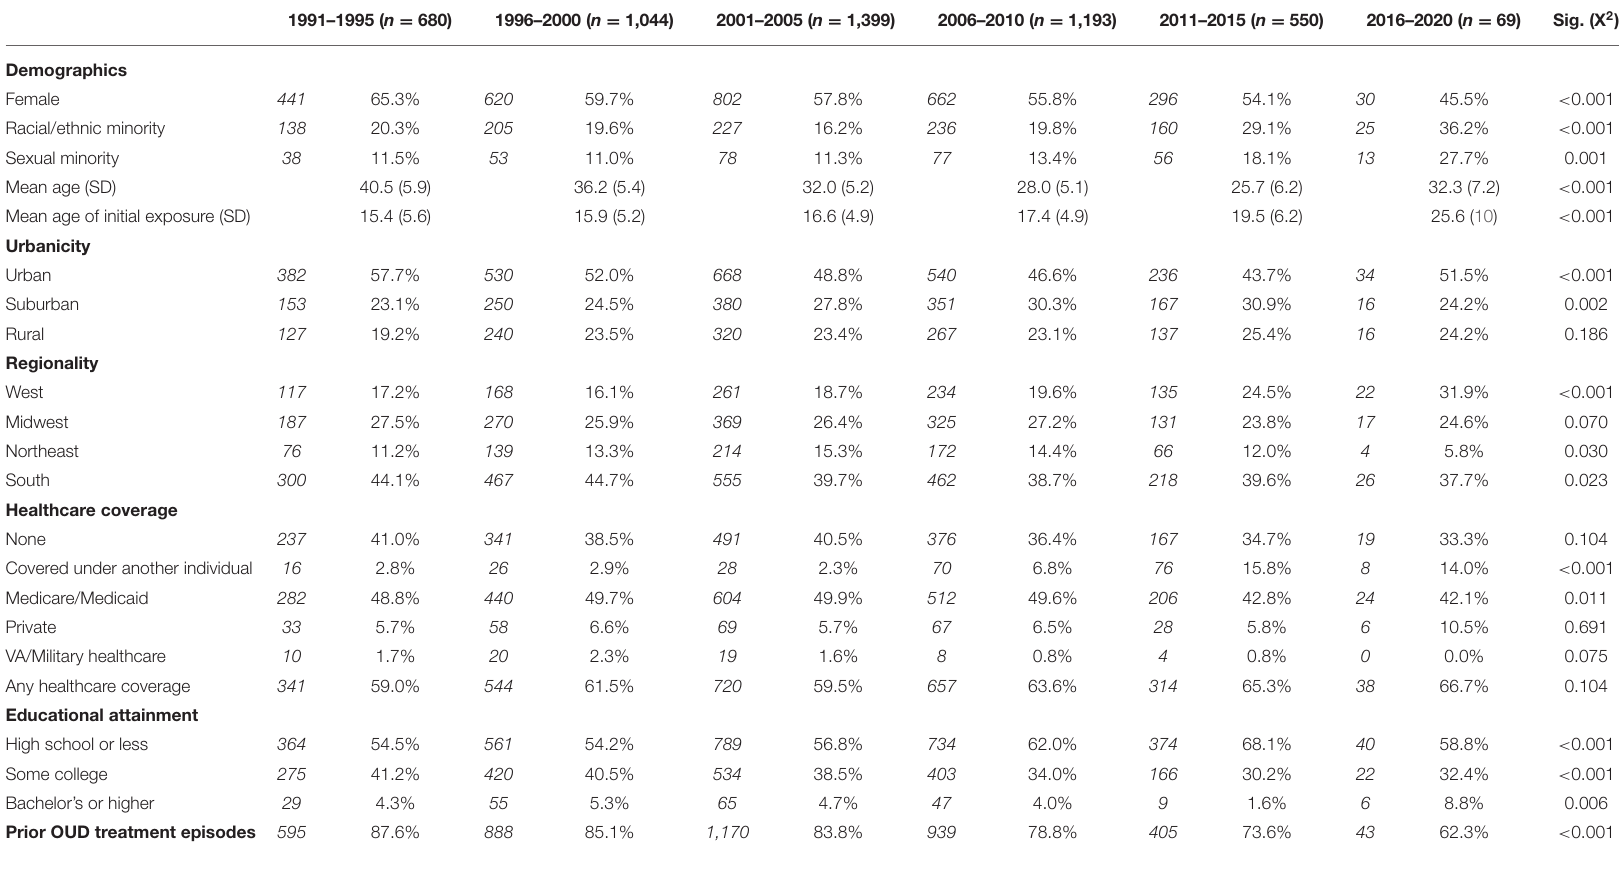
TABLE 1 | Demographic characteristics of individuals with opioid use disorder with lifetime exposure to stimulant drugs, grouped by year of initial drug